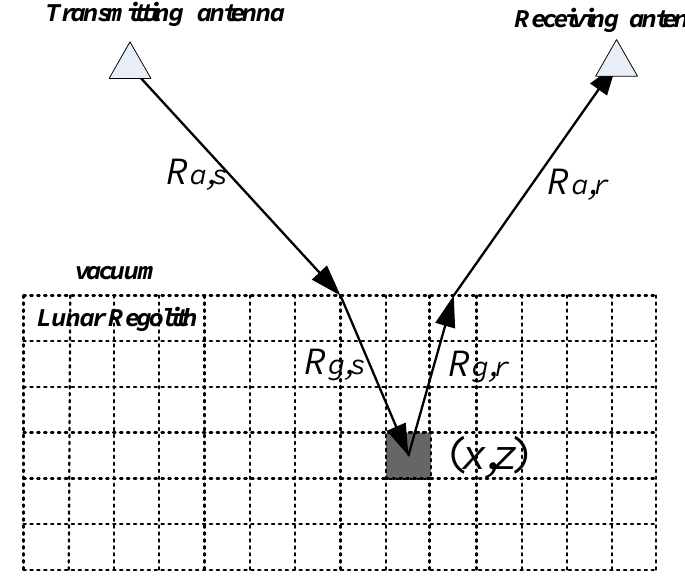
Figure 6. The schematic of pre-stack depth migration.